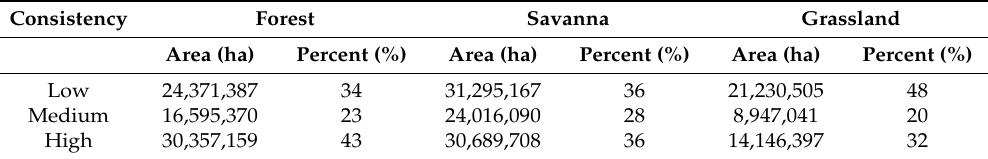
Figure 7. Classification probability maps of three native vegetation classes ( A —forest, B —savanna, and C —grassland) in the Brazilian Cerrado, indicating the levels of consistency (low: 1–11 years; medium: 12–26 years; and high: 27–33 years) observed for each class in the 1985–2017 period. Table 4. Consistency of the native vegetation classes in terms of the number of years in which the pixels were classified as the same class. Three consistency categories were considered: low: 1–11 years; medium: 12–26 years; and high: 27–33 years.